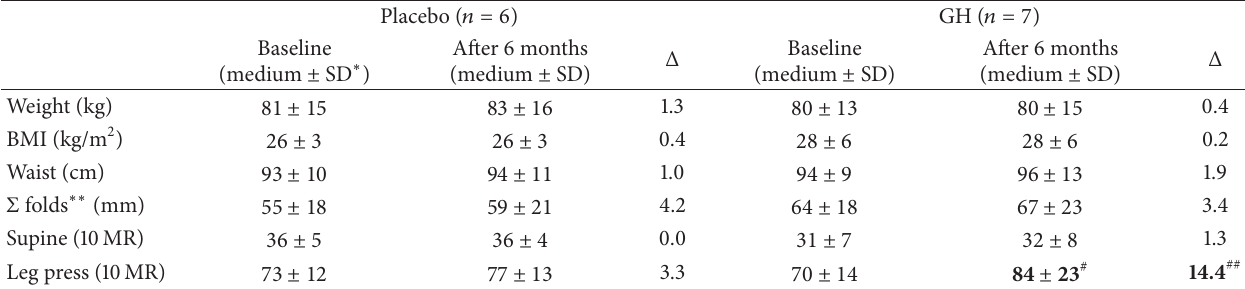
Table 2: Evaluation before and after 6 months of treatment (placebo and